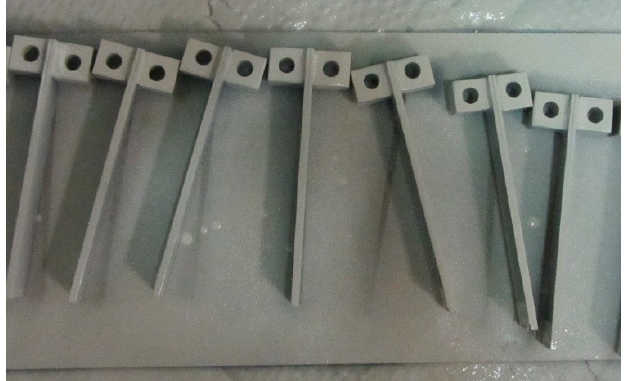
Figure 3. Double cantilever beam (DCB) samples after white painting.